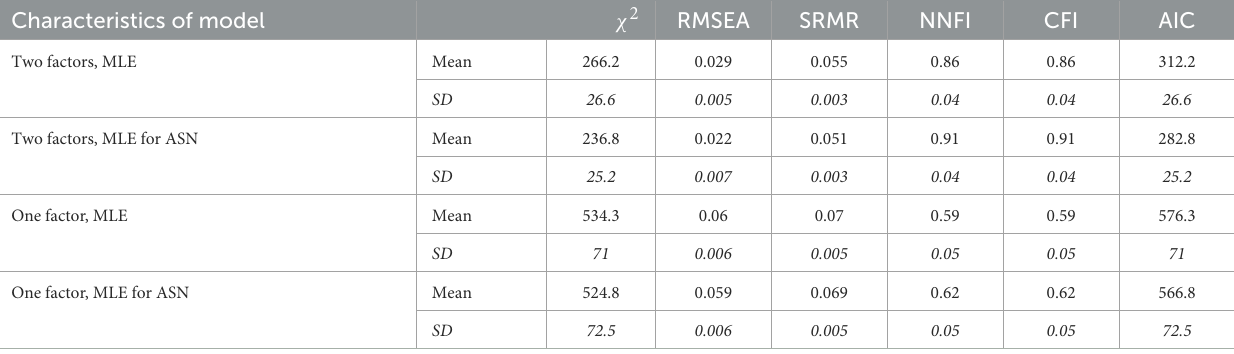
TABLE 2 Mean fit results and SDs (in italics) observed in investigating data showing (no) asymmetric non-normality (ASN) by one-factor and two-factor models using regular MLE and MLE for ASN ( N = 500). Characteristics of model